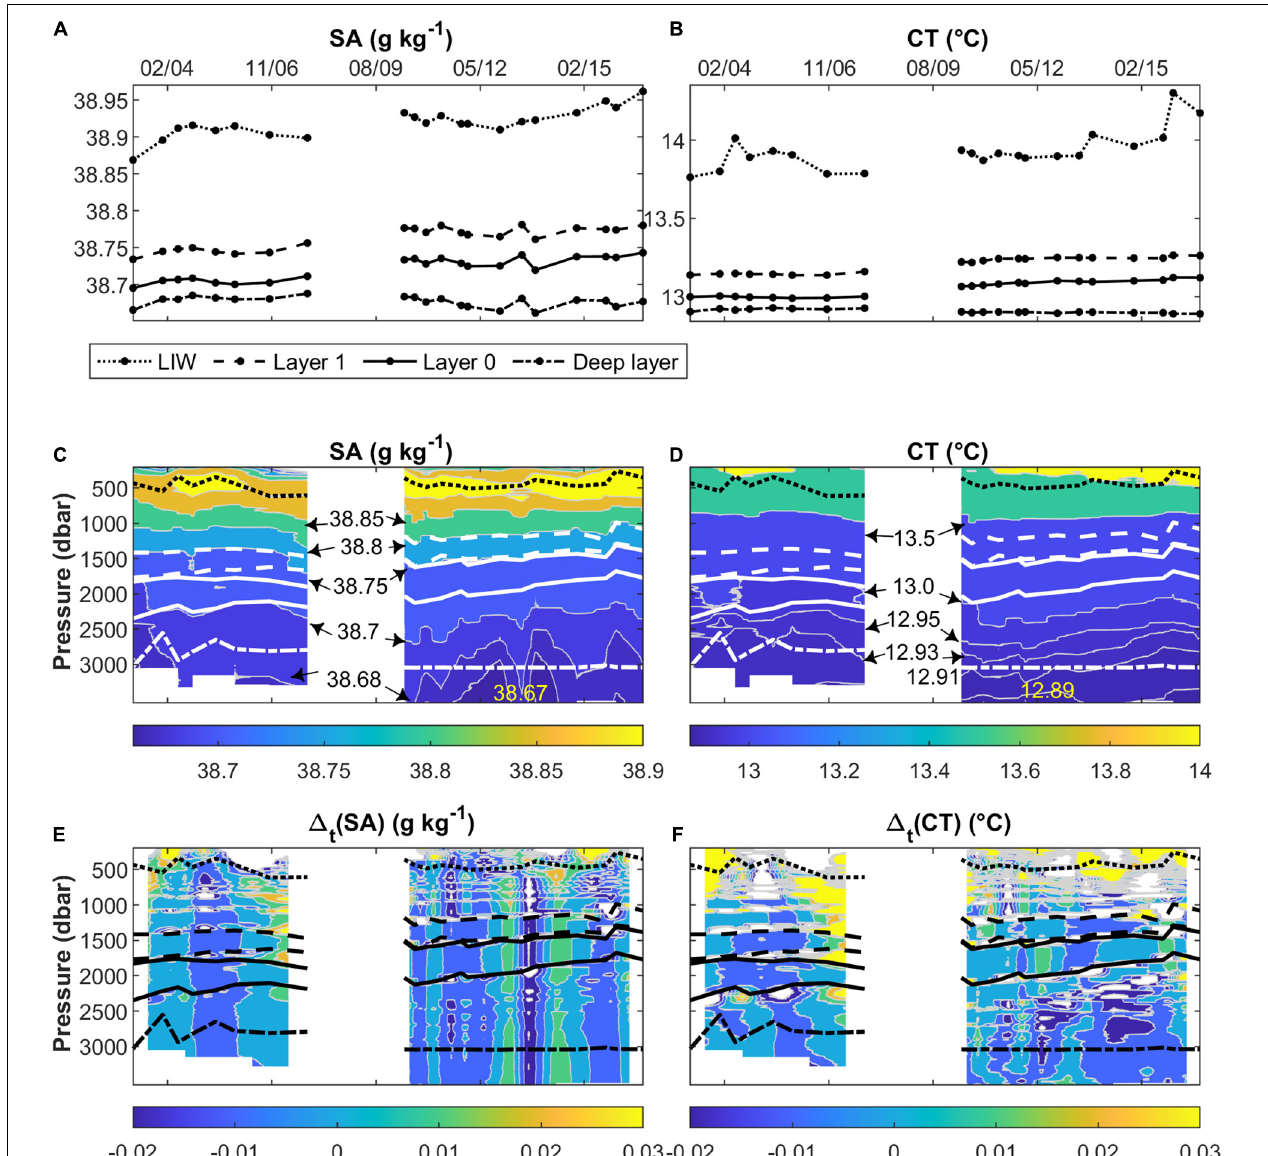
FIGURE 6 | Evolution over time of salinity (SA) and temperature (CT). (A) and (B) show the variation of the maximum salinity and its corresponding temperature value (LIW), together with the average values of SA and CT in the layers 0 and 1 of the staircases, and in the last 500 dbar above the bottom. (C) and (D) present the behaviors of salinity and temperature with respect to pressure and time. (E) and (F) the same, only this time for the calculated difference in salinity and temperature between two consecutive times instead. In (C–F) , the position of the LIW and the previously specified 0, 1 and deep layers are indicated using the types of lines ascribed to them in the legend of (A) and (B)